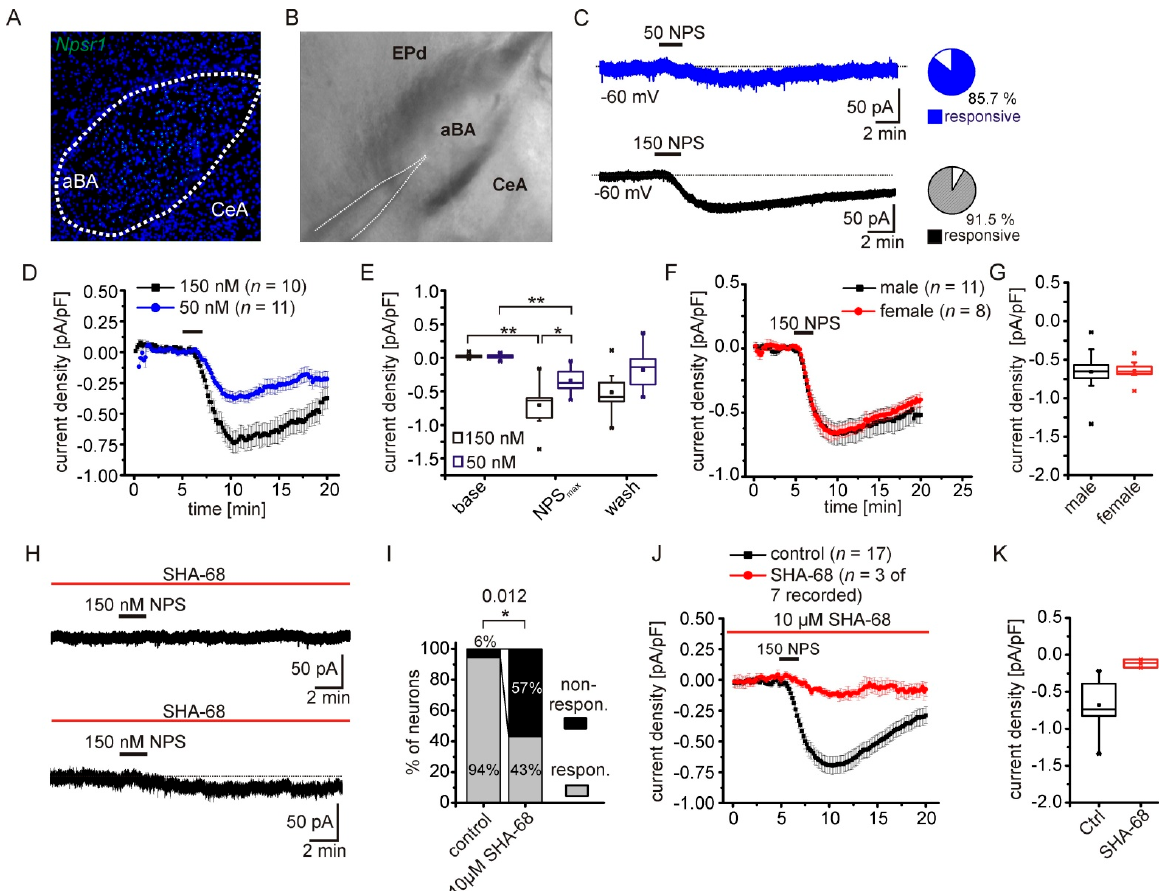
Figure 1. NPS-induced inward current in NPSR1-expressing aBA principal neurons. ( A ) Npsr1 mRNA (green) detection in neurons of the aBA by fluorescence in situ hybridization. DAPI (blue) was used to mark cellular nuclei. The medially located central nuclei of the amygdala (CeA) are devoid of Npsr1 mRNA. ( B ) Example of a coronal slice preparation used for electrophysiological recordings of aBA PNs. The white lines delineate the recording pipette. ( C ) Examples of membrane currents recorded from aBA PNs at a holding potential of -60 mV. NPSR1-dependent inward-directed currents were elicited by application of 50 nM (blue) or 150 nM (black) NPS. Pie charts show the overall fraction of NPS-responsive neurons during application of 50 or 150 nM NPS. ( D ) Time course of mean current densities elicited by 50 (blue) or 150 nM (black) NPS. NPS was applied for 2.5 min. ( E ) Quantification of recorded current densities following application of either 50 or 150 nM NPS. The maximal current densities are concentration dependent. ( F ) Time course of the NPS-induced current recorded in aBA PNs in slices from male and female mice. No sex-dependent differences were detected in the time course or in the maximal current densities ( G ). ( H ) Examples of 150 nM NPS application in the presence of the NPSR1 antagonist SHA-68 (10 µ M). Examples depict nonresponsive (upper trace) and responsive neurons (lower trace). ( I ) Fraction of responsive aBA PNs in the presence of SHA-68 and during control conditions. ( J ) Mean time course of responsive neurons in the presence of SHA-68 ( n = 3) and during control recordings. ( K ) In the presence of SHA-68, the maximal current density was significantly reduced. * p < 0.05; ** p <